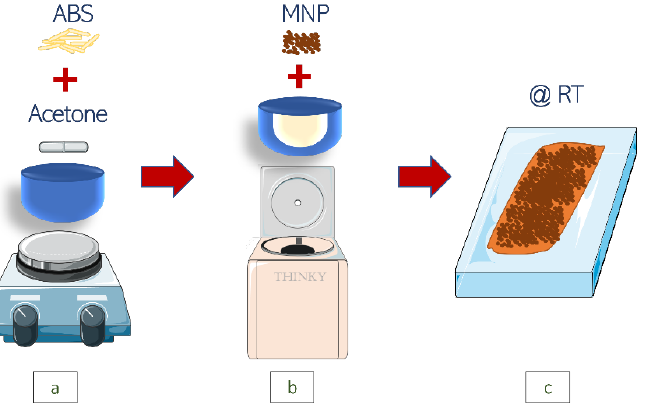
Figure 1. Preparation of polymer composites. ( a ) Dissolution of 2 g of ABS in 10 mL of acetone; ( b ) Thinky ARE-250 planetary mixer; ( c ) solvent casting over a clean glass substrate at room tempera- ture.